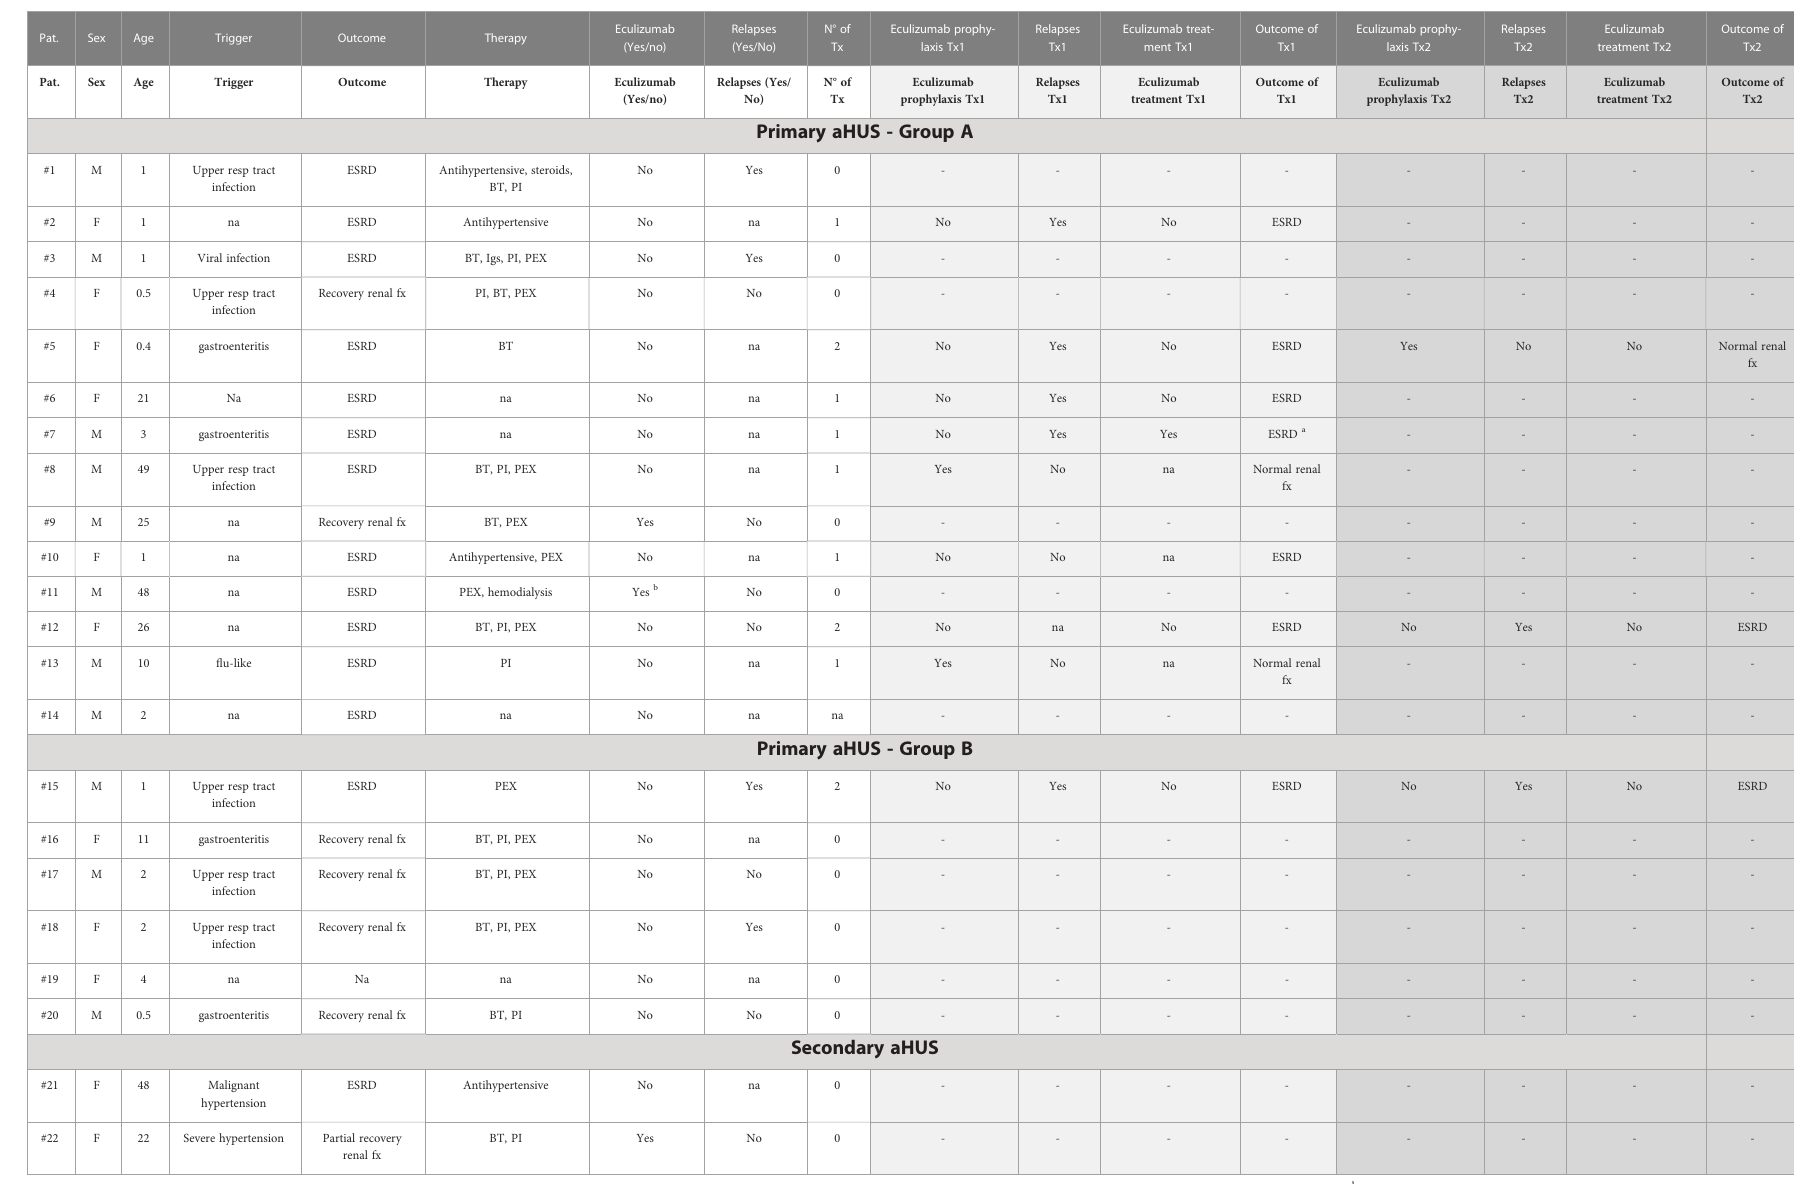
TABLE 3 Demographic and clinical fi ndings of aHUS patients carrying uncommon CFH-CFHR SVs. Pat.